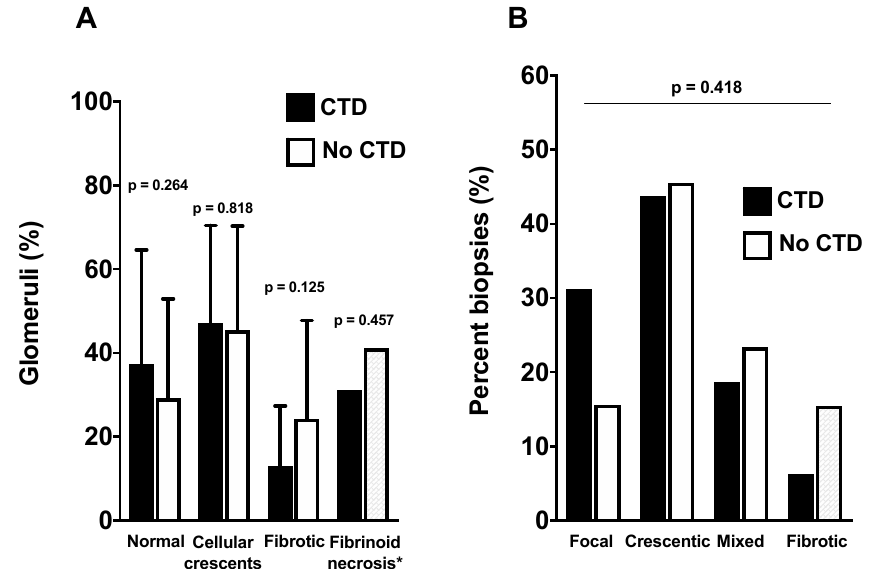
Figure 3. Analysis of light microscopy of kidney biopsy and comparison according to groups. ( A ) percentage of normal, crescentic and fibrotic glomeruli according to the presence or absence of CTD. ( B ) histopathological classes of ANCA ‐ GN according to groups.